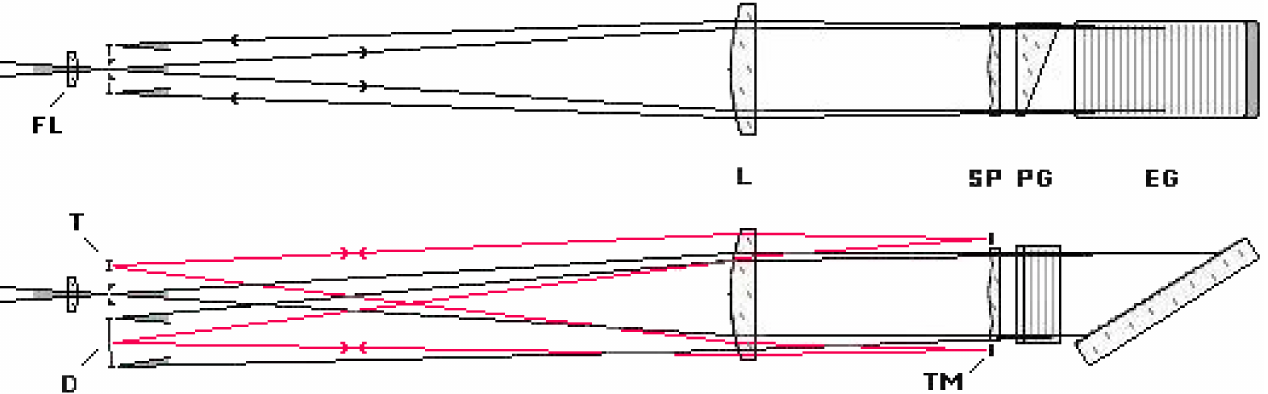
Figure 1. Optical path scheme of the 20-cm pupil aperture CFHT-CassHawEc spectrograph including a field-lens (FL). The telemeter (T) uses two replica telemeter mirrors (TM) for the focusing set-up of a 2D detector (D). Each replica mirror TM compensates aberration of the convex-plane lens (L). Their shape provide an equivalent correction to that of the extended-size Schmidt plate (SP). Pair of pencil rays for telemeter in red